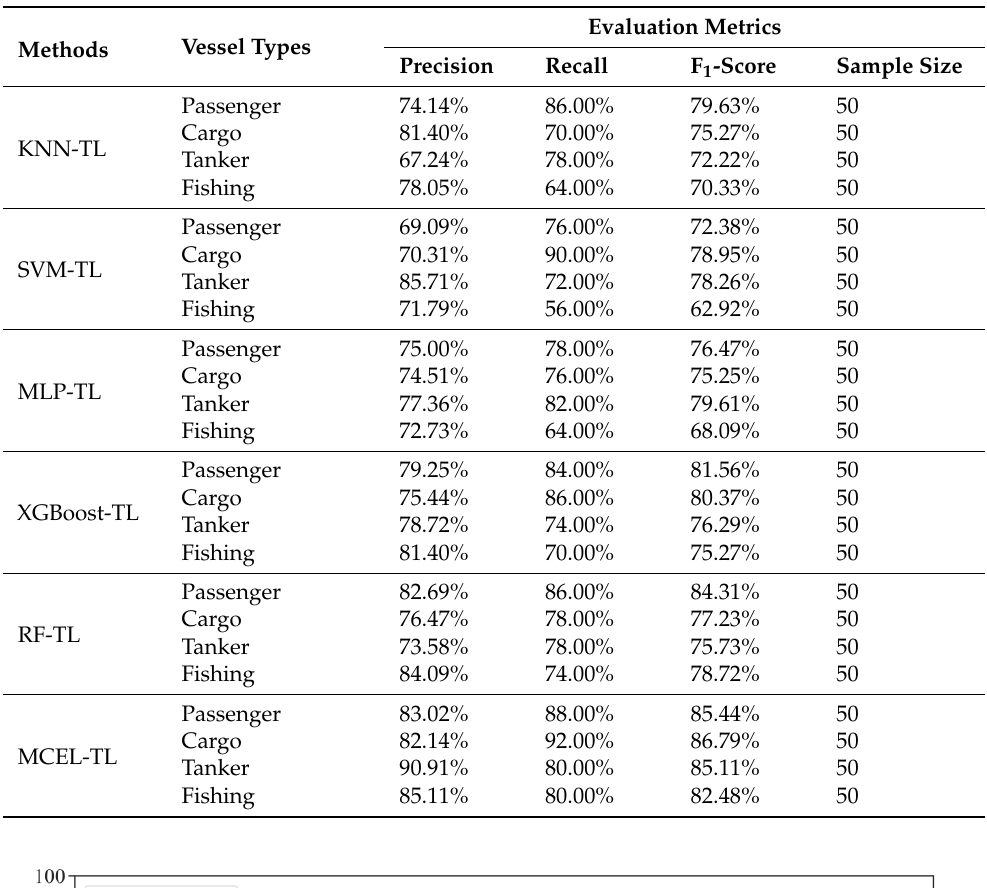
Table 6. The ship classification results of each classification method on the SAR test set with AIS data transfer.